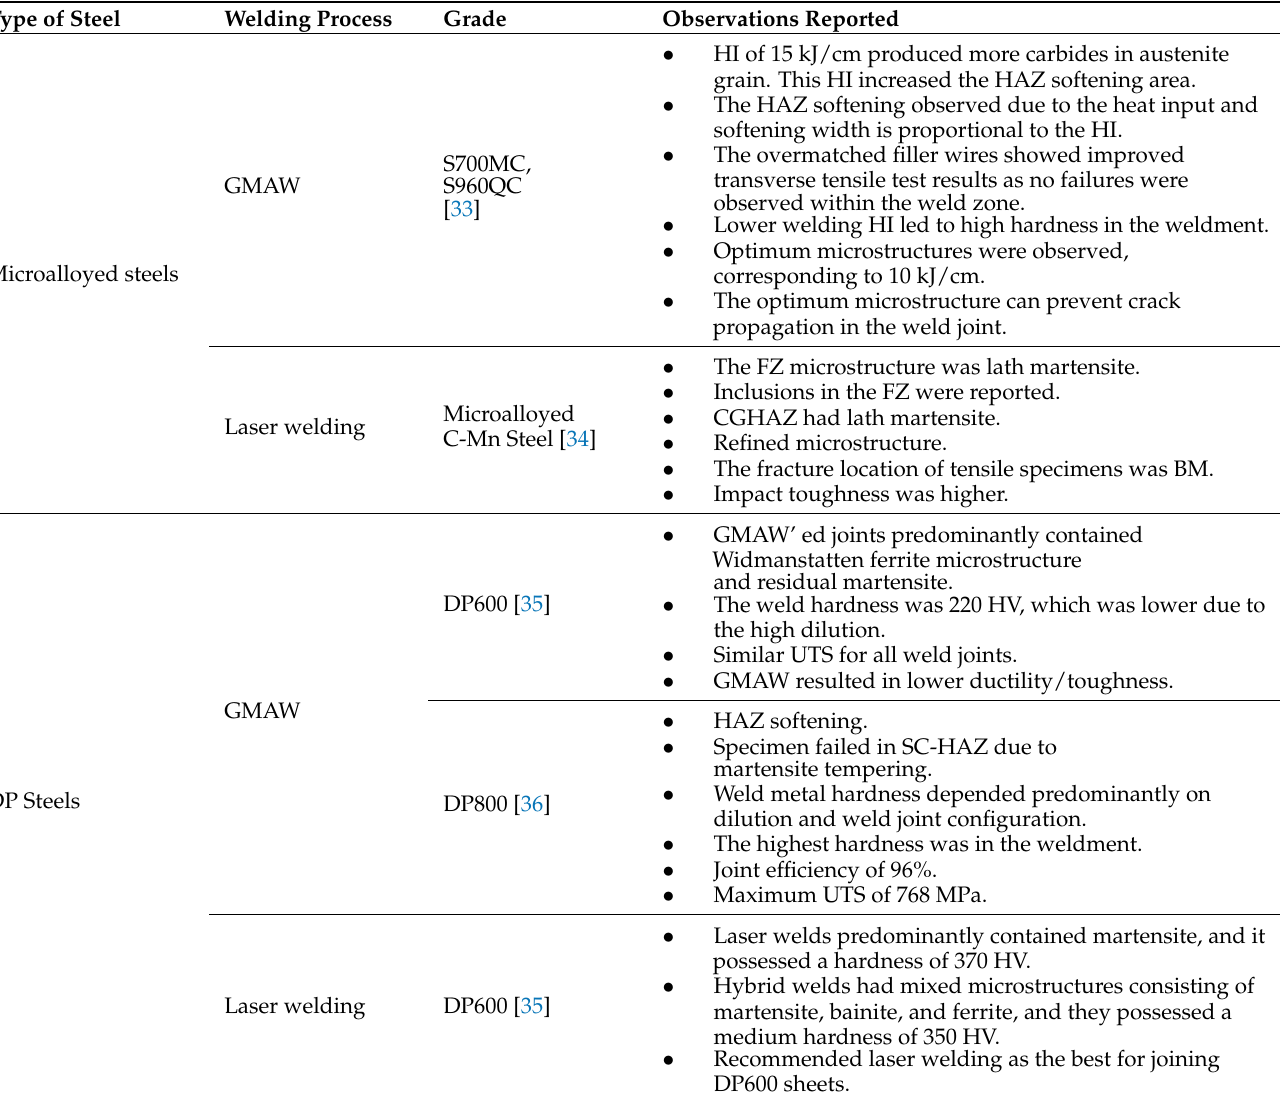
Table 1. Weld joint mechanical properties and microstructural changes during AHSS